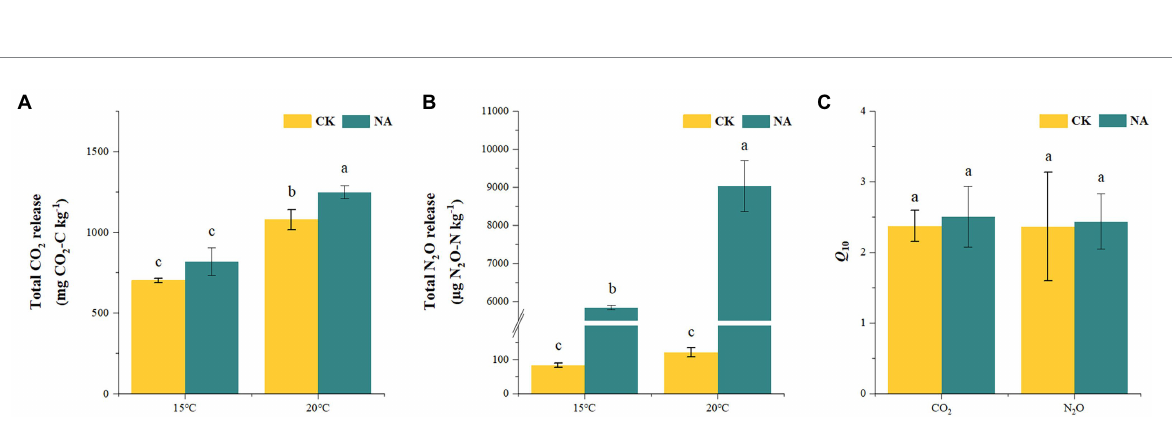
FIGURE 2 Effects of temperature rising and nitrogen addition on soil total CO 2 (A) and N 2 O (B) release and their temperature sensitivity ( Q 10 ) (C) in permafrost peatland. CK, control; NA, add 50 mg N kg − 1 soil. Different lowercase letters in the figure indicate significant differences in the means between different